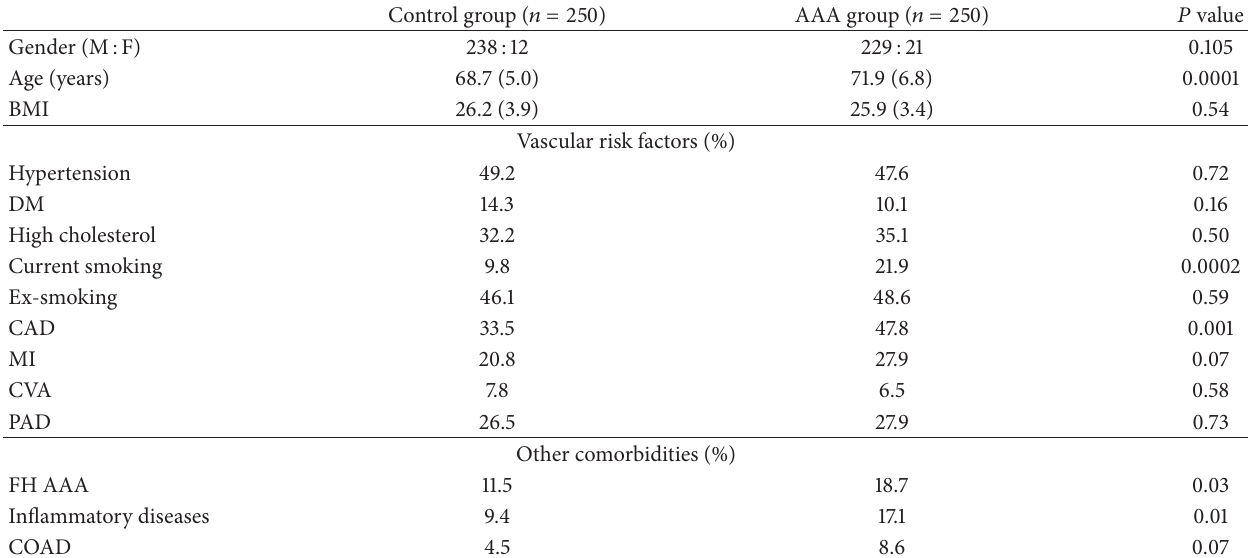
Table 1: Patient characteristics in the control and AAA groups.